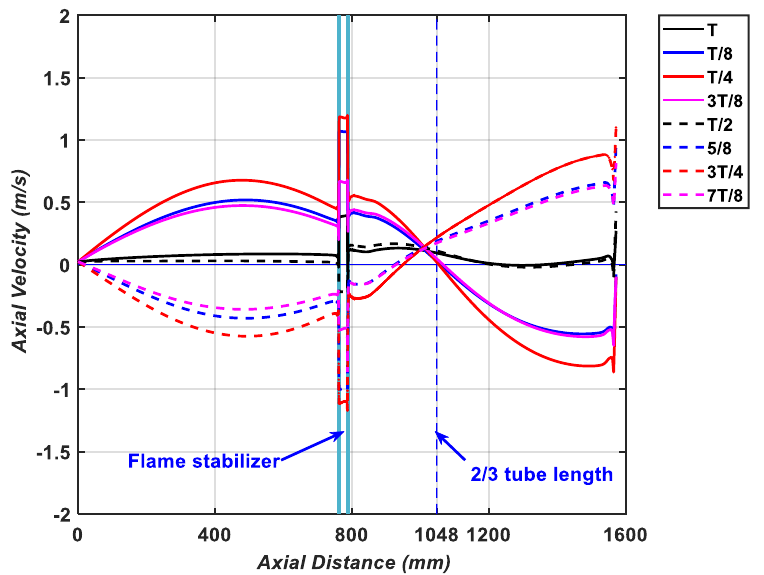
Figure 13. Axial velocity distribution along the centerline at different times of a limit cycle [m/s].